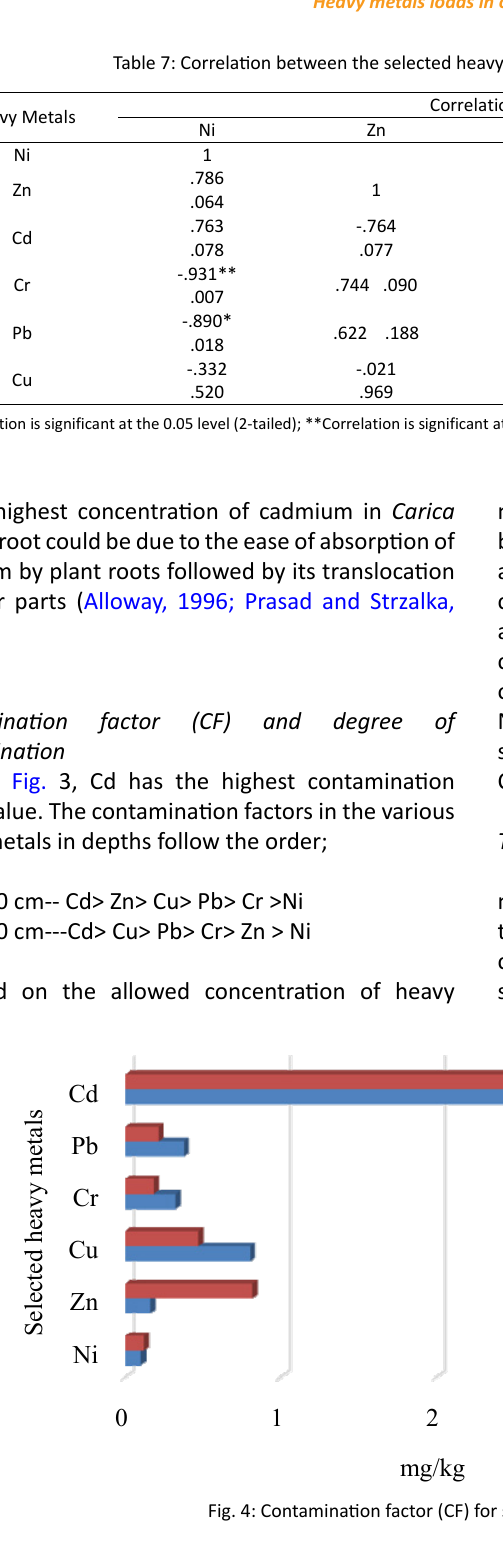
Correlation of heavy metals (mg/kg)